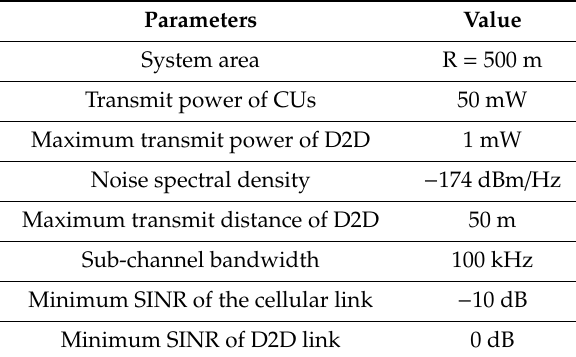
Table 2. Main simulation parameters.